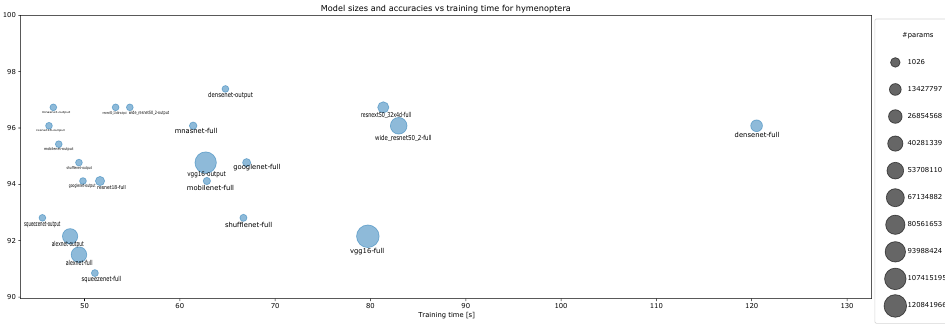
Figure A13. Accuracy vs. training time and model size for Hymenoptera for ten-episode